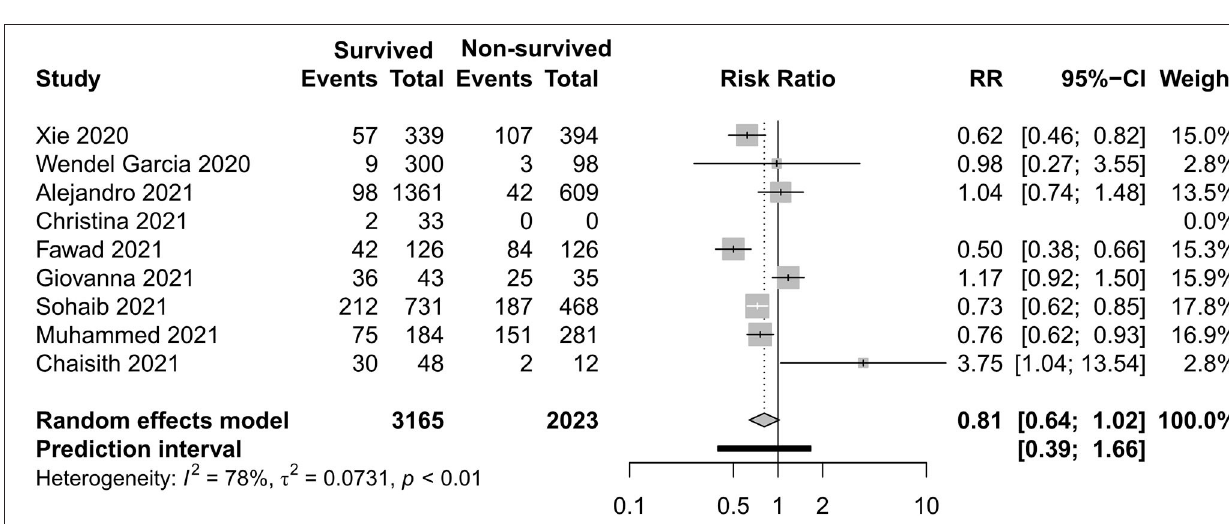
FIGURE 8 | Risk ratio of high-flow nasal oxygenation between survived and non-survived patients.